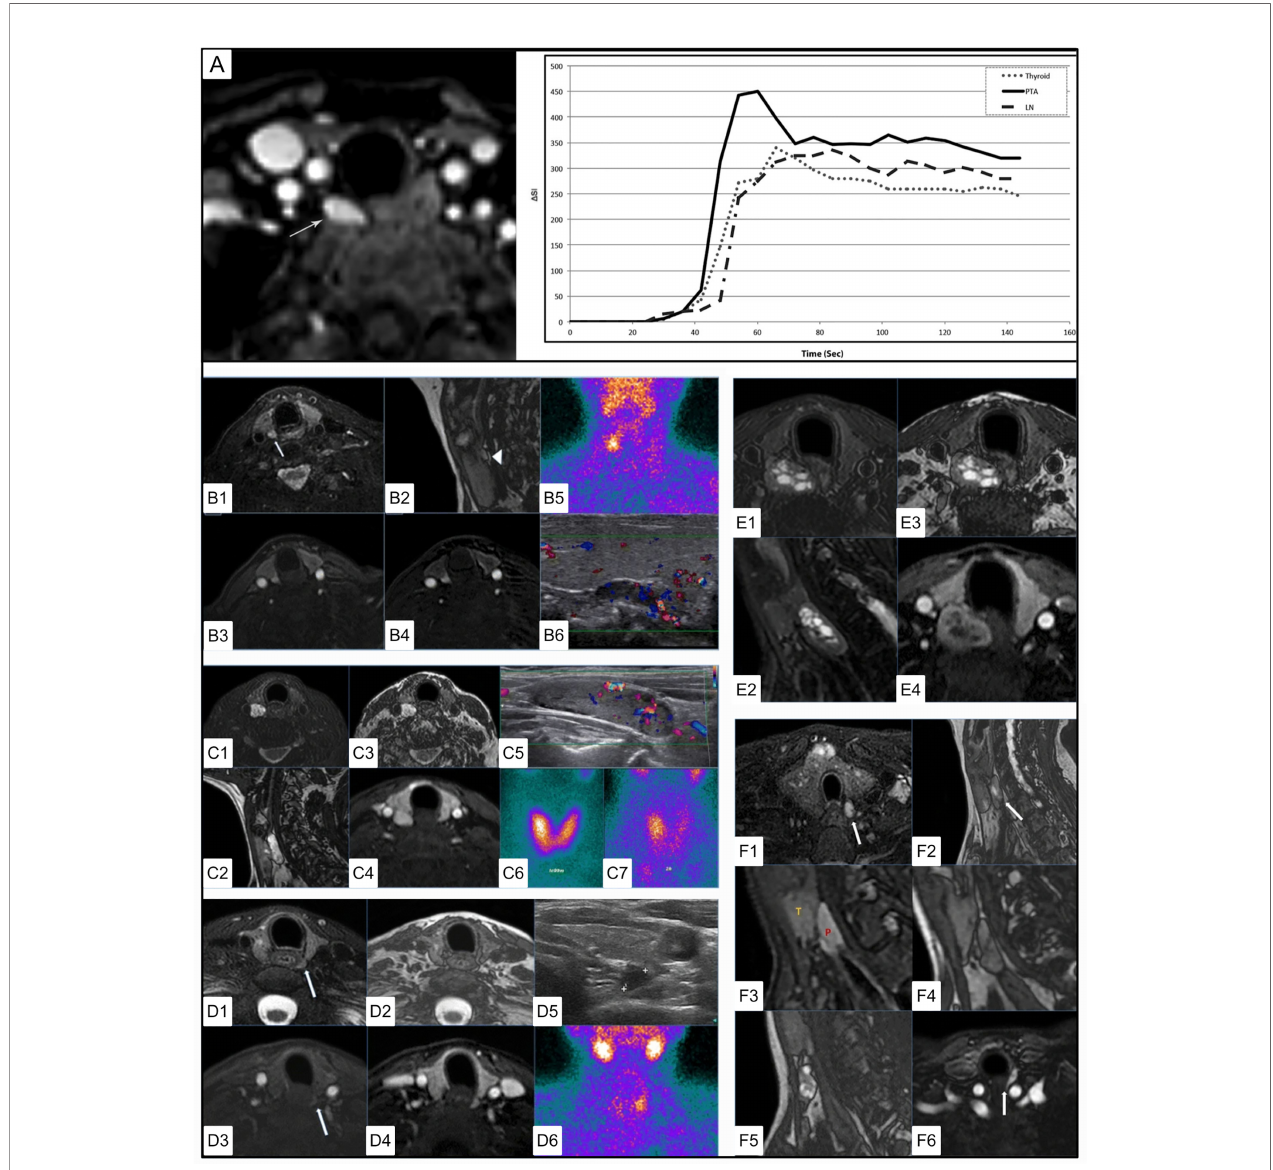
FIGURE 10 | 4DMRI imaging of parathyroid adenomas. (A) Axial arterial phase post contrast fat saturation T1 MRI of PA at the tracheoesophageal groove (white arrow) in a 47 yo F with primary hyperparathyroidism (PTH - 164 pg/mL, Ca2+ = 10.8). Graph depicts contrast-time curve analysis from ROI placed over the PA (solid), a lymph node (dashed), and the thyroid (dotted), showing relative faster time to peak (TTP), increased wash in and increased wash out values from the PA. (B) 4DMRI of PA posterior to the right thyroid mildly hyperintense relative to the thyroid on axial T2 fat saturation [ (B1) , white arrow] and separated by cleavage plane on sagittal out of phase imaging [ (B2 , white arrow] images with avid arterial enhancement greater than thyroid on T1 post contrast (B3) and T1 post contrast subtraction imaging (B4) and comparative coronal 99m Tc-sestamibi (B5) and ultrasound imaging (B6) . (C) 4DMRI of PA posterior to the right thyroid gland with marked relative T2 fat saturation hyperintensity (C1) , oblong appearance without reliable cleavage plane on out of phase imaging in sagittal (C2) or axial (C3) planes, and arterial enhancement similar to the thyroid gland (C4) and associated ultrasound (C5) and early (C6) and delayed (C7) phase 99m Tc-sestamibi. (D) Dynamic MRI of PA posterior to the left thyroid slightly hyperintense similar to thyroid on axial T2 (D1) , with thin cleavage plane on axial out of phase (D2) , with mild enhancement on early axial T1 post-contrast subtraction (D3) and similar to the thyroid gland on delayed axial T1 post-contrast subtraction (D4) and comparative ultrasound (D5) and coronal 99m Tc-sestamibi (D6) . (E) 4DMRI of PA posterior to the right thyroid with mixed cystic and solid components causing mass effect on the esophagus displacing it to the left on axial (E1) and oblong appearance on sagittal (E2) T2 fat saturation, with cleavage plane on axial out of phase (E3) , and partial enhancement similar to the thyroid gland on T1 post-contrast fat saturation (E4) . (F) Summary of MRI features of PA including T2 fat saturation hyperintensity (F1) , oblong appearance (F2) , cleavage plane between the thyroid and PA (F3) , which can be emphasized by india ink artifact on out of phase imaging (F4) , ‘ marbled ’ appearance (F5) , fast and strong enhancement on T1 post-contrast (F6) . Reproduced with permission from: (A) Nael K, Hur J, Bauer A, Khan R, Sepandari A, Inampudi R, et al. Dynamic 4D MRI for Characterization of Parathyroid Adenomas: Multiparametric Analysis. AJNR Am J Neuroradiol. 2015;36: 2147 – 2152. doi:10.3174/ajnr.A4425 (B – F) Sacconi B, Argirò R, Diacinti D, et al. MR appearance of parathyroid adenomas at 3 T in patients with primary hyperparathyroidism: what radiologists need to know for pre-operative localization. European Radiology. 2016 Mar;26(3):664-673. DOI: 10.1007/s00330-015-3854-5